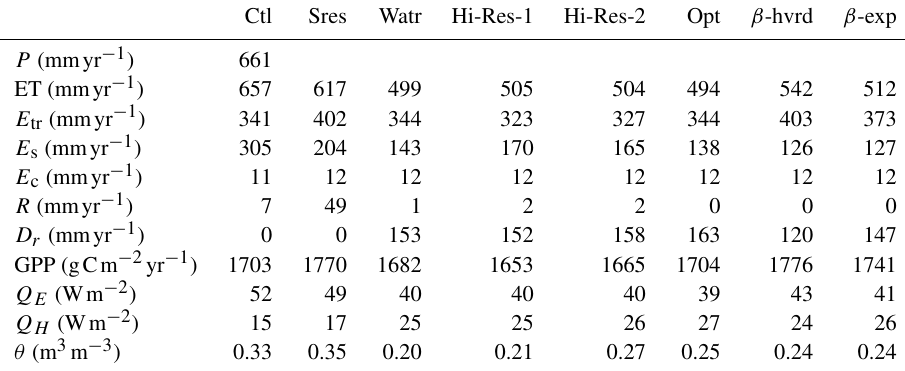
Table 3. Average values from each experiment. Precipitation ( P ), total evapotranspiration (ET), transpiration ( E tr ), soil evaporation ( E s